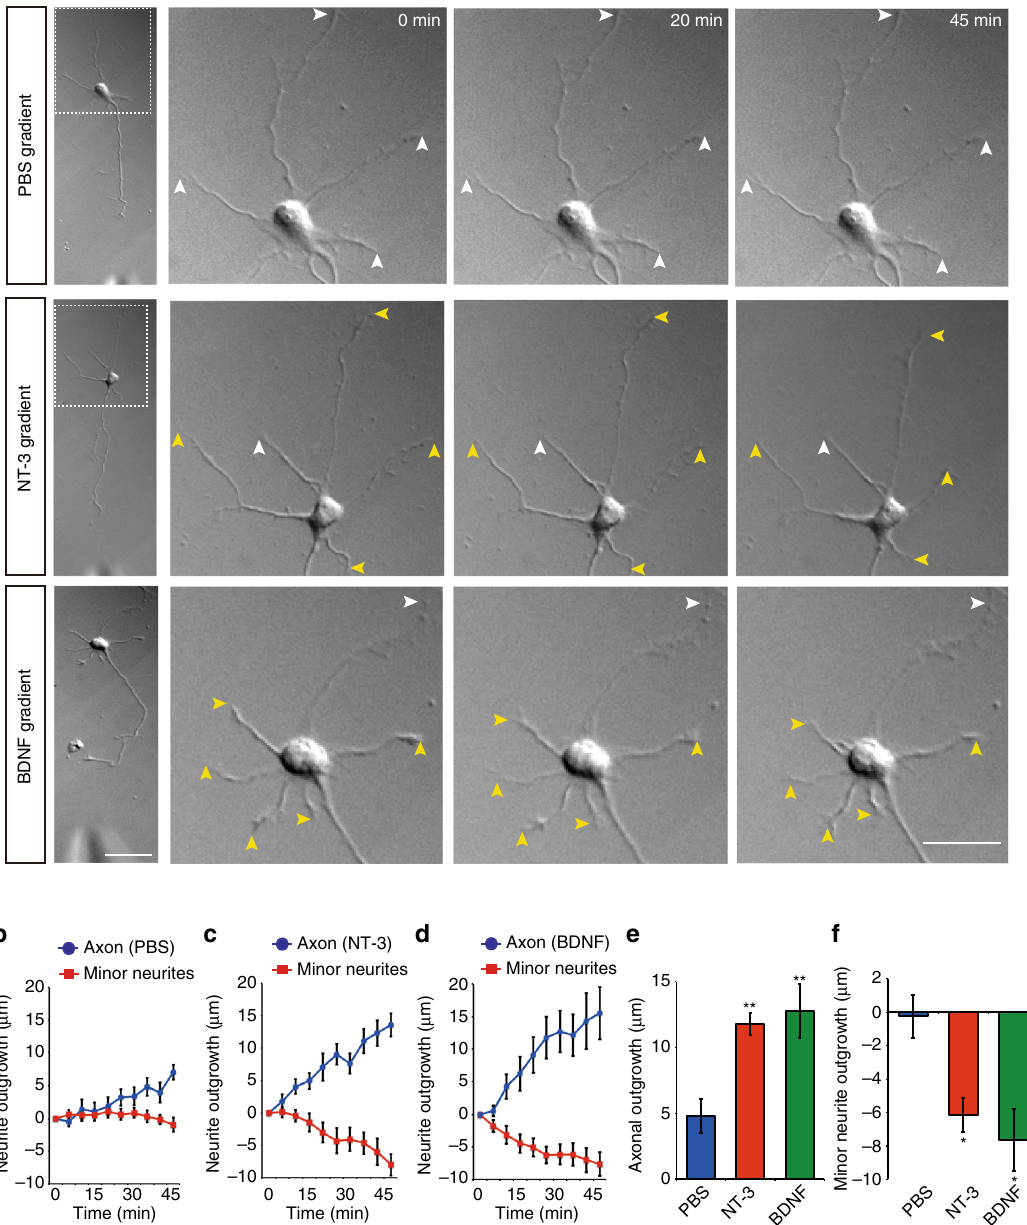
Fig. 1 Local application of neurotrophins to an axon terminal induced remote minor neurite retraction. a Local application of neurotrophins induced remote minor neurite retraction. PBS, NT-3, or BDNF was locally applied to the axon terminal of a stage 3 hippocampal neuron, and the images following this application are presented. Yellow and white arrowheads indicate the retracting and resting minor neurites, respectively. Scale bar, 50 μ m. b – d Time course of changes in the lengths of the axon ( blue ) and minor neurites ( red ) from a single neuron. e , f Axonal outgrowth (PBS = 14, NT-3 = 15, BDNF = 16 neurons from three independent experiments) and minor neurite outgrowth (PBS = 45, NT-3 = 39, BDNF = 31 neurites from three independent experiments) were measured. Error bars represent SEM. * P < 0.05 and ** P <